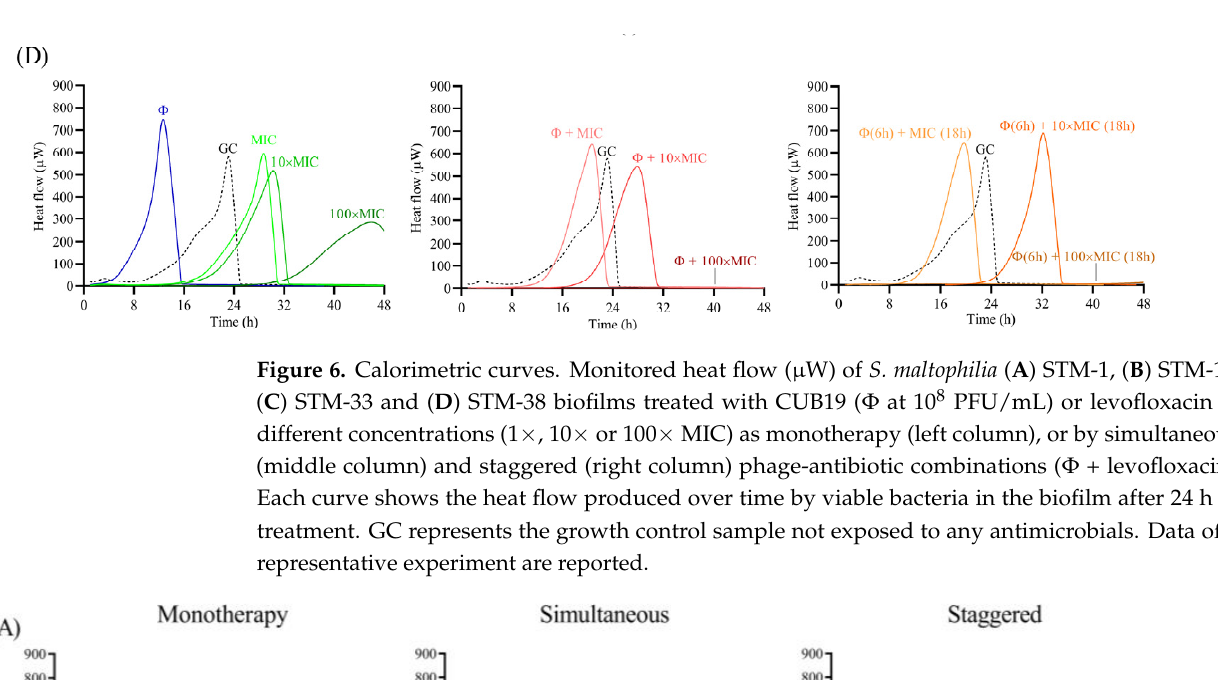
Figure 7. Calorimetric curves. Monitored heat flow (µW) of S. maltophilia ( A ) STM-1, ( B ) STM-19, ( C ) STM-33 and ( D ) STM- 38 biofilms treated with CUB19 (Φ at 10 8 PFU/mL) or cefiderocol at different concentrations (1×, 10× or 100× MIC) as monotherapy (left column), or by simultaneous (middle column) and staggered (right column) phage- antibiotic combinations (Φ + cefider ocol). Each curve shows the heat flow produced over time by viable bacteria in the biofilm after 24 h of treatment. GC represents the growth control sample not exposed to any antimicrobials. Data of a representative experiment are reported.